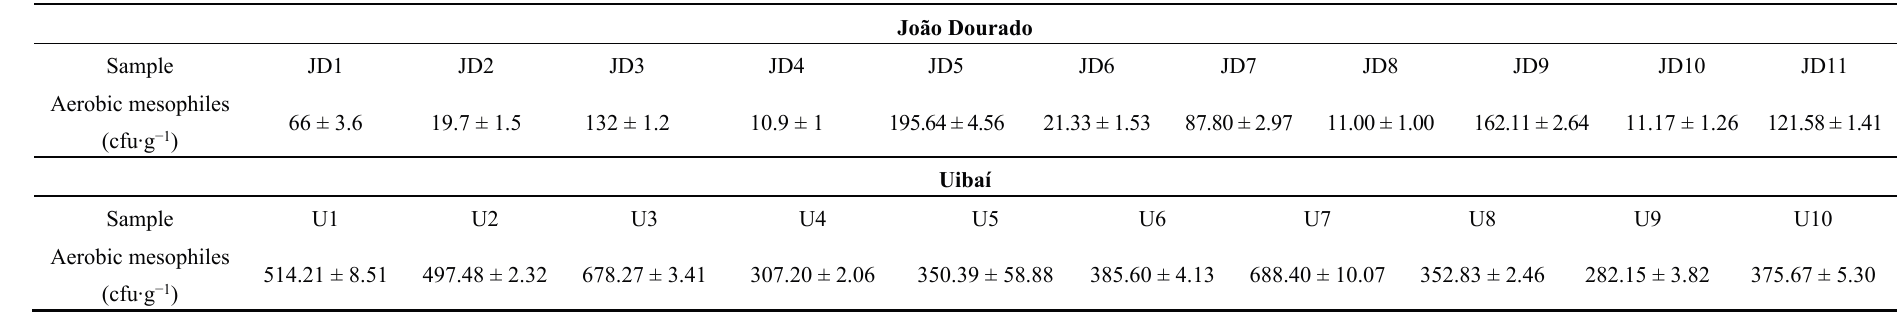
Table 1. Results obtained for the aerobic mesophiles (cfu·g − 1 ) in the bee pollen samples from the two locations.